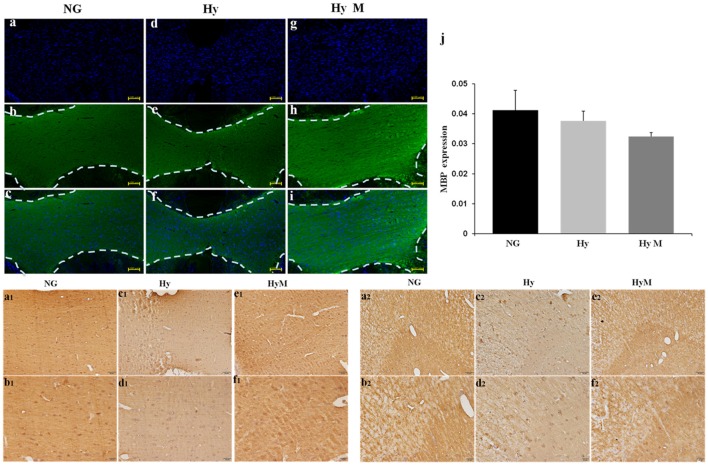
Immunostaining for detection of white matter changes in P60d rat brain after hypoxia. (a–i) The representative images of DAPI (a,d,g), MBP immunofluorescence staining (b,e,h) and merged ones (c,f,i) in corpus callosum in indicated groups and (j) the quantification of MBP fluorescence intensity. Scale bar = 100 μm. n = 3 animals per group. Data expressed as means ± SEM. (a1–f1) The representative images of MBP immunohistochemistry staining in corpus callosum of indicated groups. Scale bar = 50 μm in the top panel and scale bar = 20 μm for the bottom panel. (a2–f2) The representative images of MBP immunohistochemistry staining in cingulum in indicated groups. Scale bar = 50 μm in the top panel and scale bar = 20 μm for the bottom panel. NG represents normal control rats, Hy represents hypoxia rats, Hy M represents hypoxia rats with minocycline treatment.